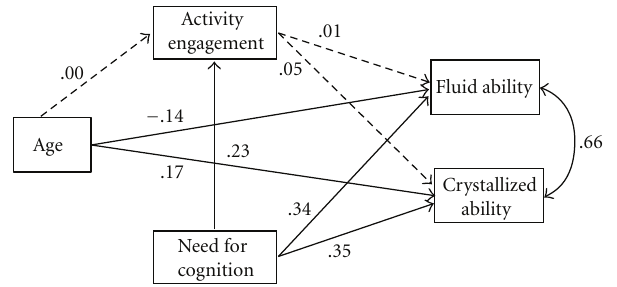
Figure 2: Mediation model of age di ff erences in cognitive ability with standardized path parameters. Note: error terms for activity engagement, fluid and crystallized ability have been omitted to sustain graphical clarity. Dashed paths represent nonsignificant pathways ( P > . 05). The double-headed arrow indicates a